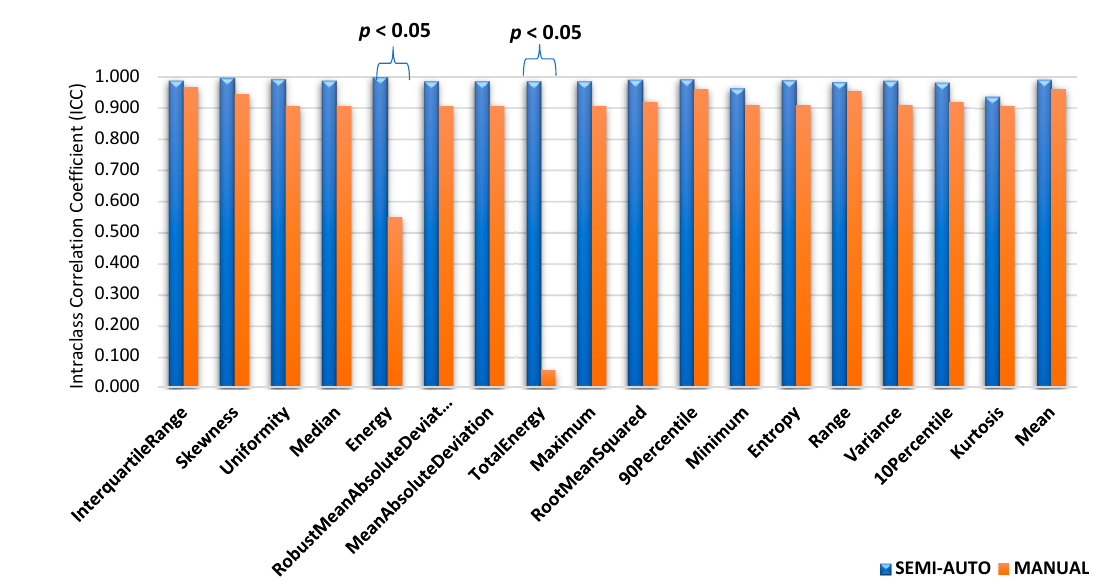
Figure 6. Intra-class correlation coefficient (ICC) value comparisons for first order statistical charac- teristics for ( p < 0.05).